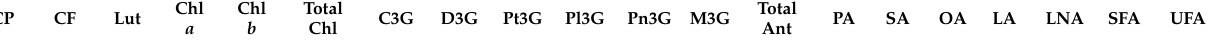
Table 2. Simple linear correlation coefficients for 20 seed composition traits of 469 black soybean germplasms with green cotyledons, including check cultivars ‘Cheongja 3’ and ‘Cheongja’, over three years